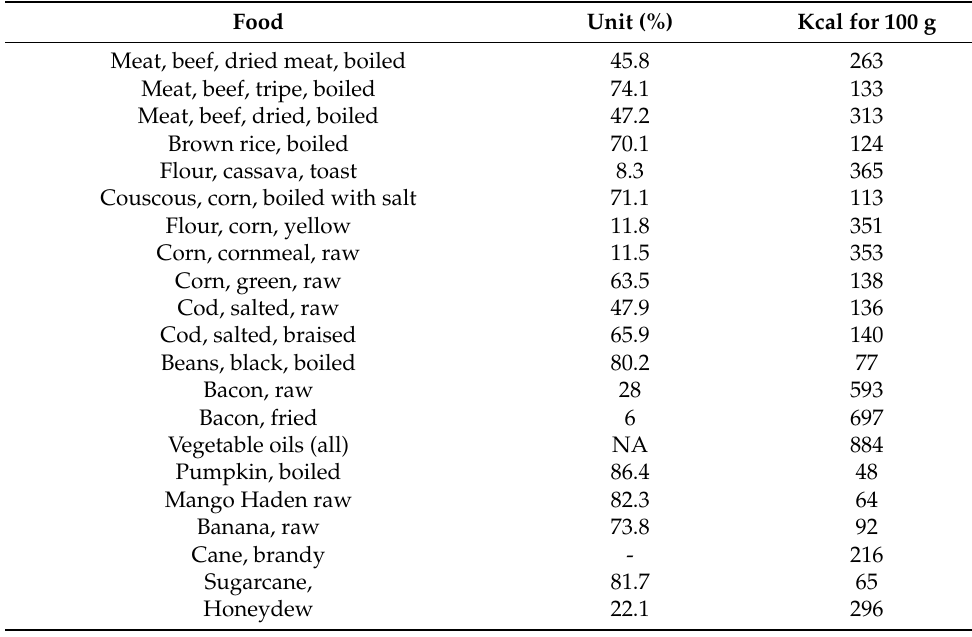
Table 3. Energy that is contained in the food served to the enslaved. Food Unit (%) Kcal for 100